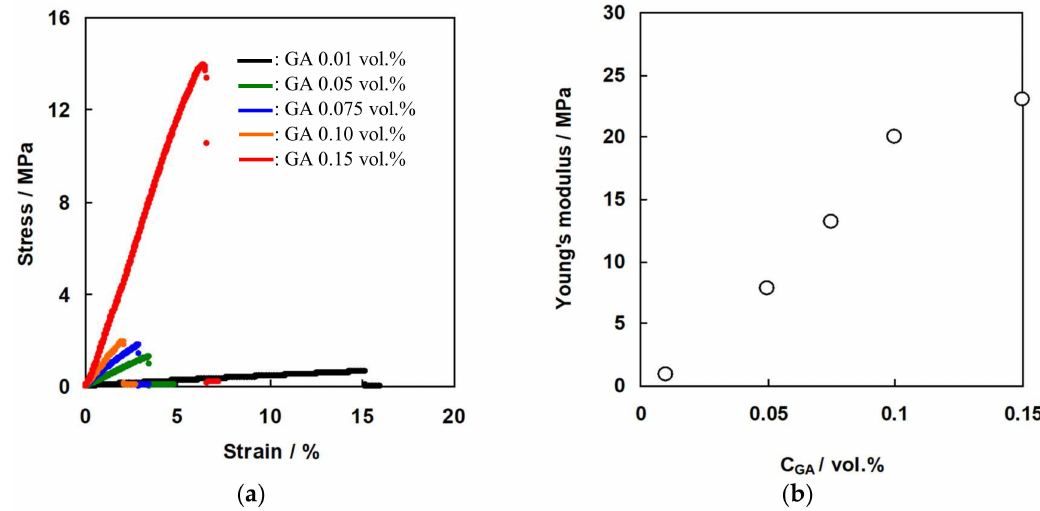
Figure 11. ( a ) Stress-strain curve of C-HF membranes. ( b ) Young’s modulus of C-HF membranes as a function of GA concentration.